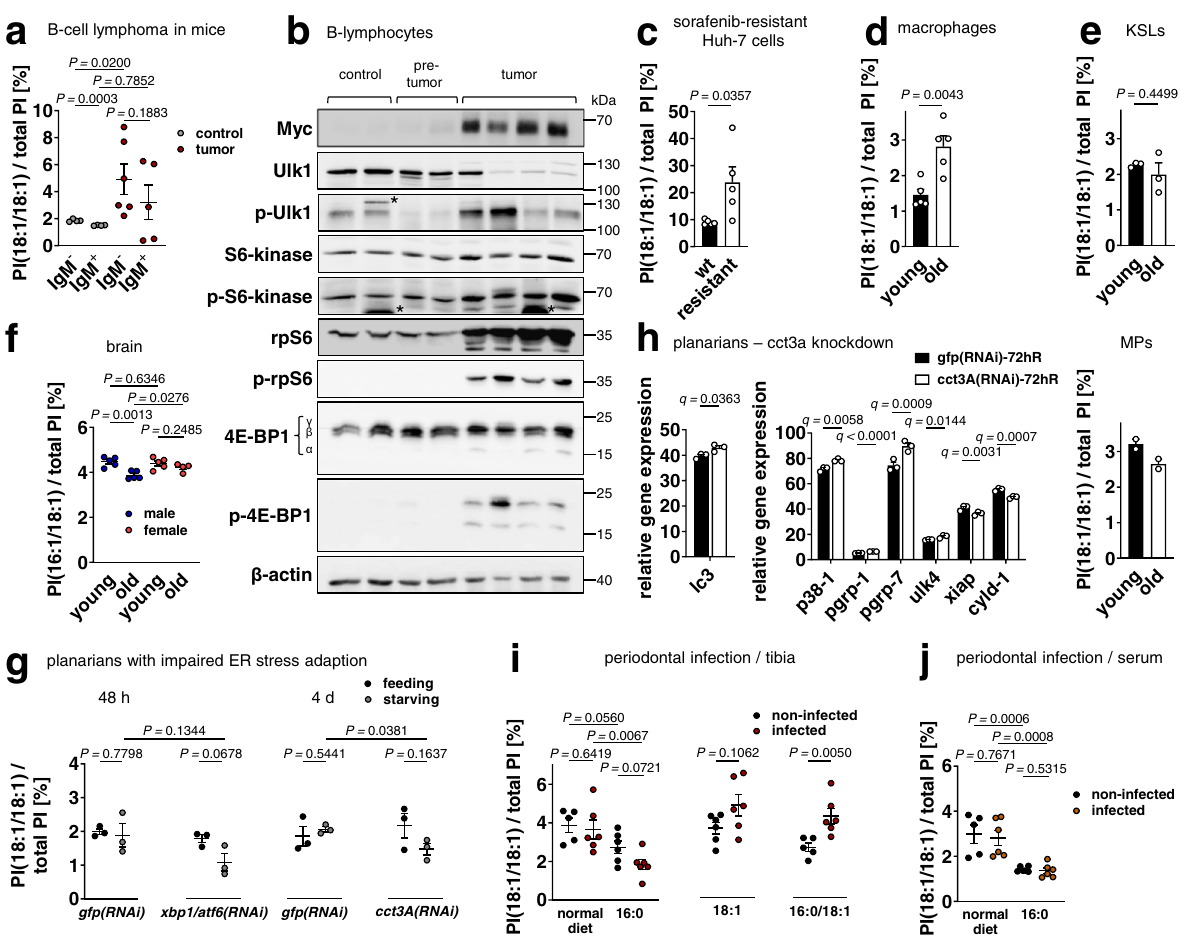
Fig. 9 PI(18:1/18:1) in systems with varying stress tolerance. a , c – e , g - j Cellular proportion of PI(18:1/18:1). a IgM - and IgM + B-cells and B-cell lymphoma from E µ -Myc-transgenic mice. b Expression, phosphorylation, and substrate turnover of the autophagy-regulatory proteins Ulk1, S6-kinase, and 4E-BP1. Western blots are representative of two independent experiments; * non-speci fi c bands. Each line corresponds to an individual animal. c Wild-type ( ‘ wt ’ ) and sorafenib-resistant ( ‘ resistant ’ ) Huh-7 hepatocarcinoma cells. d Resident peritoneal macrophages from young (6-8 months) and old mice (26 months). e Hematopoietic stem cells (KSLs, upper panel) and myeloid progenitor cells (MPs, lower panel) from young and aged mice. f Cellular proportion of PI(16:1/18:1) in brain from young (6-8 month) and old male and female mice (26 month). g , h In fl uence of starvation on planarians with impaired ER stress adaption. g Lipids were extracted from either 48 h (left panels) or 4 days (right panels) regenerating planarians. gfp dsRNA ( gfp(RNAi) ) was injected as control. h Relative expression in TPMs of differentially regulated genes related to p38 MAPK activation and stress signaling based on the transcriptome analysis of starved, gfp or cct3A RNAi-treated planarians at 72 h of regeneration. Signi fi cance was determined by q -value (false discovery rate (FDR)) < 0.1 for pairwise comparisons. i , j Mice were inoculated with P. gingivalis and housed for 16 weeks on normal, 16:0-enriched, or 18:1-enriched diet or fi rst for eight weeks on 16:0-enriched and then eight weeks on 18:1-enriched diet. Mean + s.e.m. and single data from n = 2 ( e , lower panel), n = 3 ( e , upper panel, g , h ), n = 4 ( a for control, f for old female), n = 5 ( a for IgM + tumor, c , d, f , i , normal diet for non-infected mice and 16:0/18:1-treated non-infected mice, j , normal diet for non-infected mice), n = 6 ( a for IgM - tumor, i , j ). P values as indicated; two-tailed unpaired student t test ( c , d , e , g ) of log data ( a , f , i , j